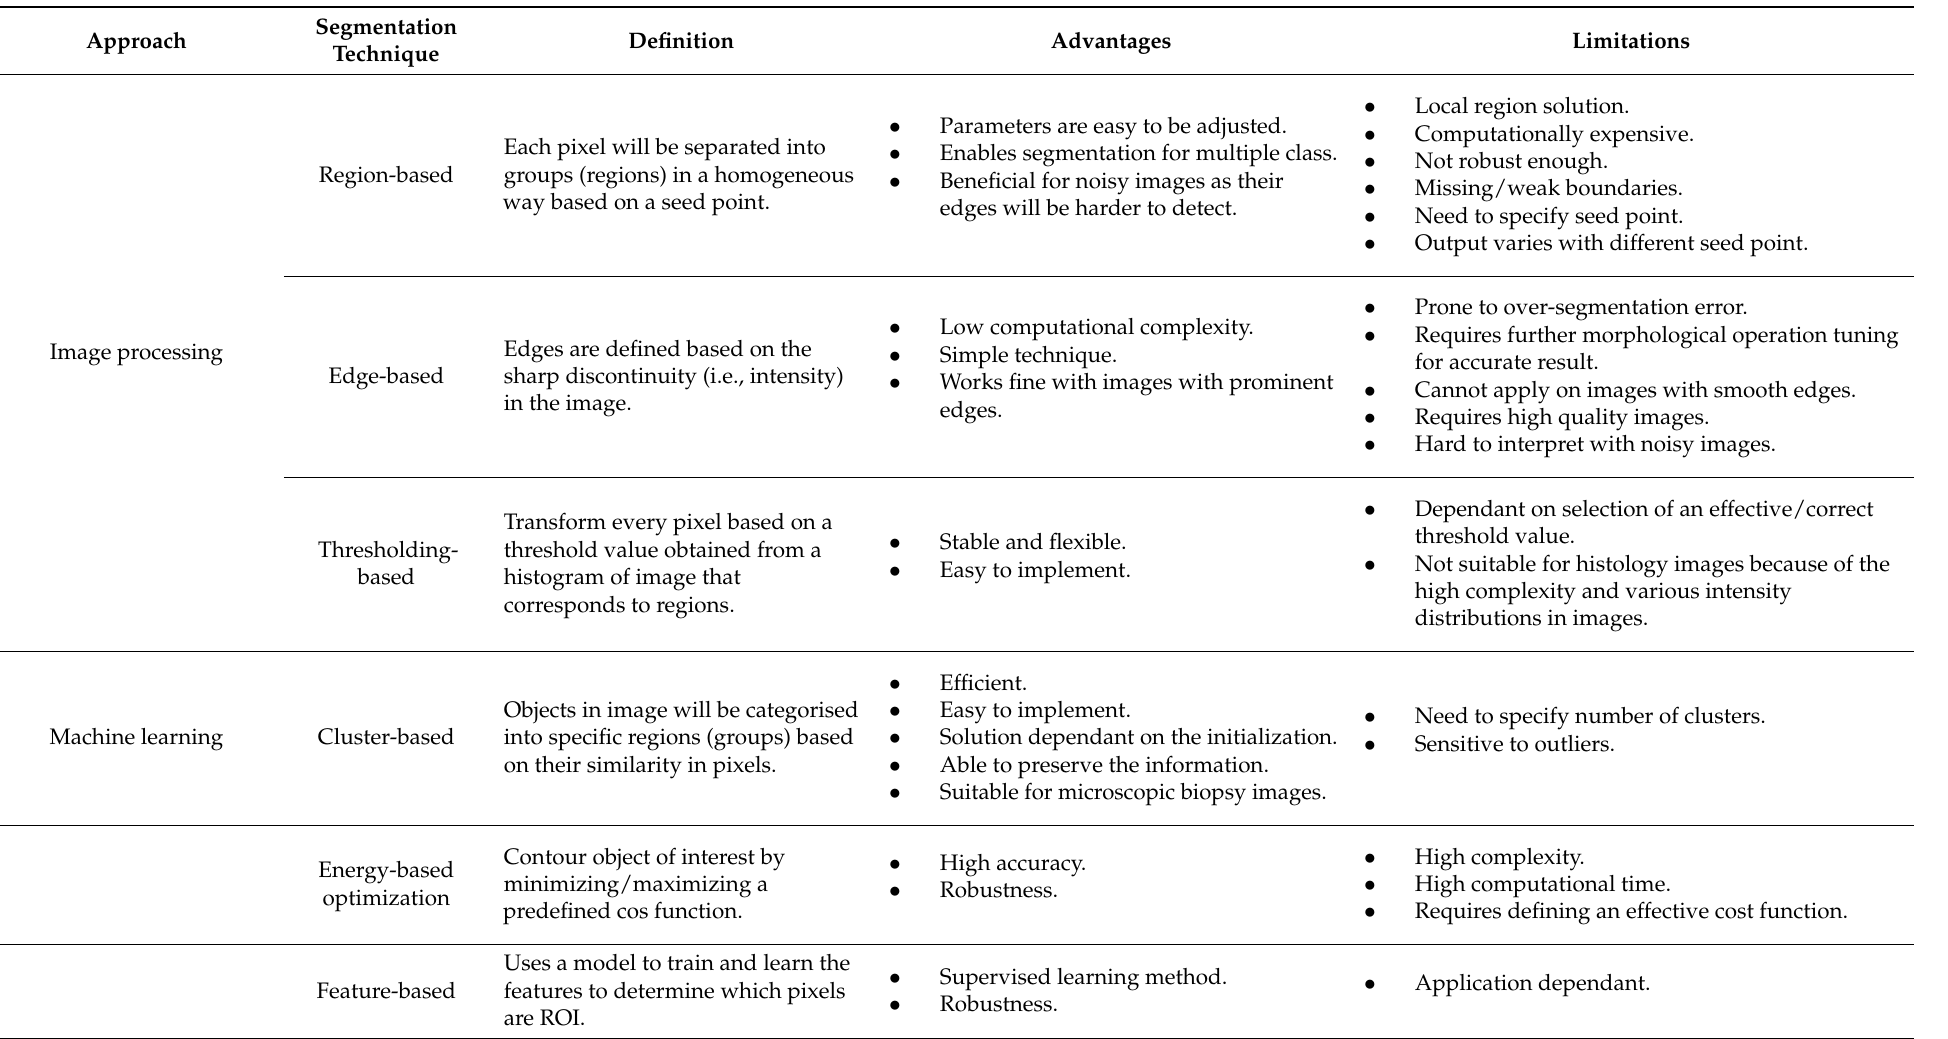
Table 4. Summary of segmentation approaches along with their definition, advantages, and